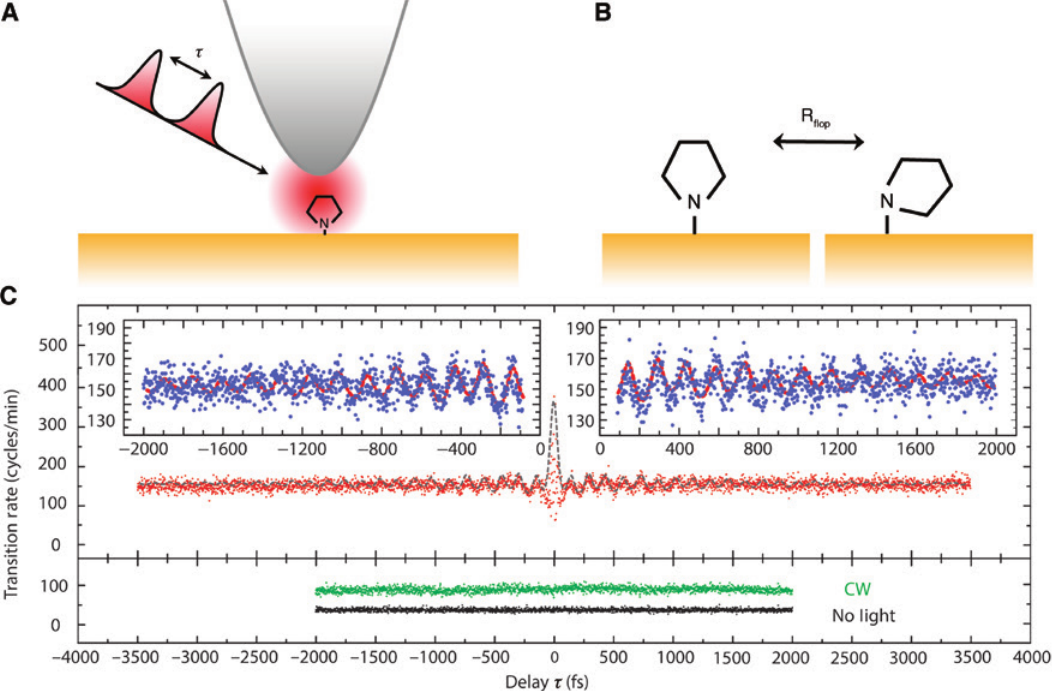
Figure 12: Non-optical detection of vibrational coherence in a single molecule using electron tunneling as a probe in a scanning tunneling microscopy (STM)